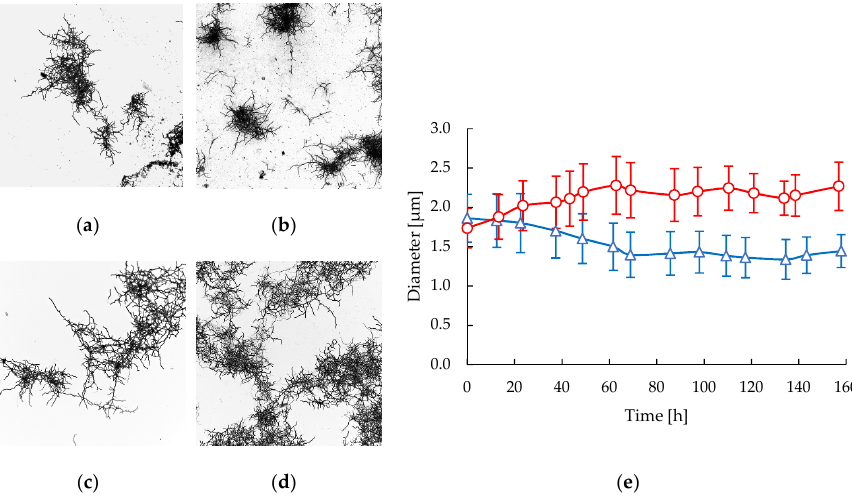
Figure 2. Morphological response of S. clavuligerus in STR (triangles) and CT (circles) bioreactors: ( a ) Mycelia in STR at 22 h; ( b ) Mycelia in STR at 86 h; ( c ) Mycelia in CT at 23 h. ( d ) Mycelia in CT at 87 h; ( e ) Time course of mycelial diameter in STR (blue) and CT (red).